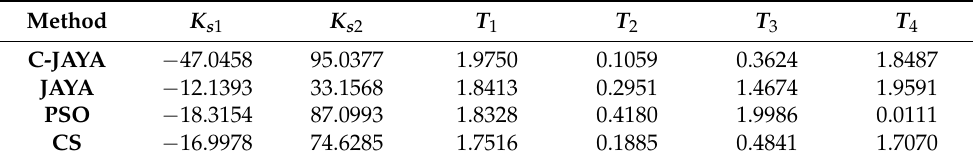
Table 1. Optimal obtained parameters.